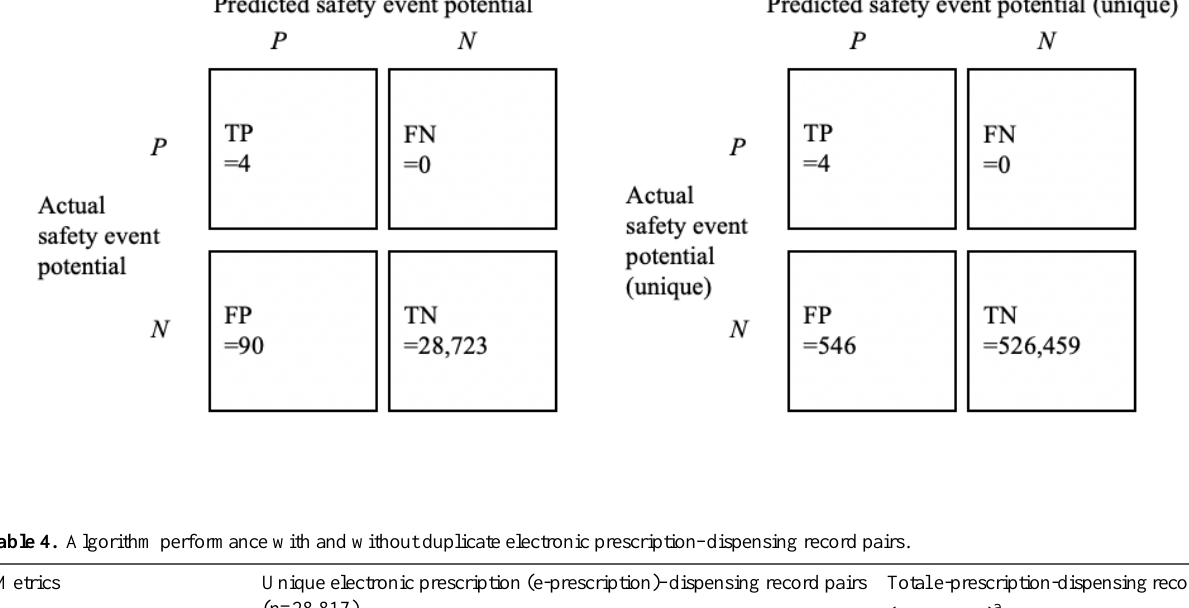
Total e-prescription-dispensing record pairs (n=527,009)